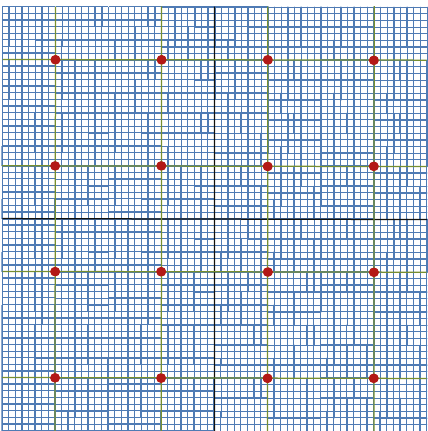
Figure 8: Constellation diagram of 16-QAM showing 5-bit accu- racy